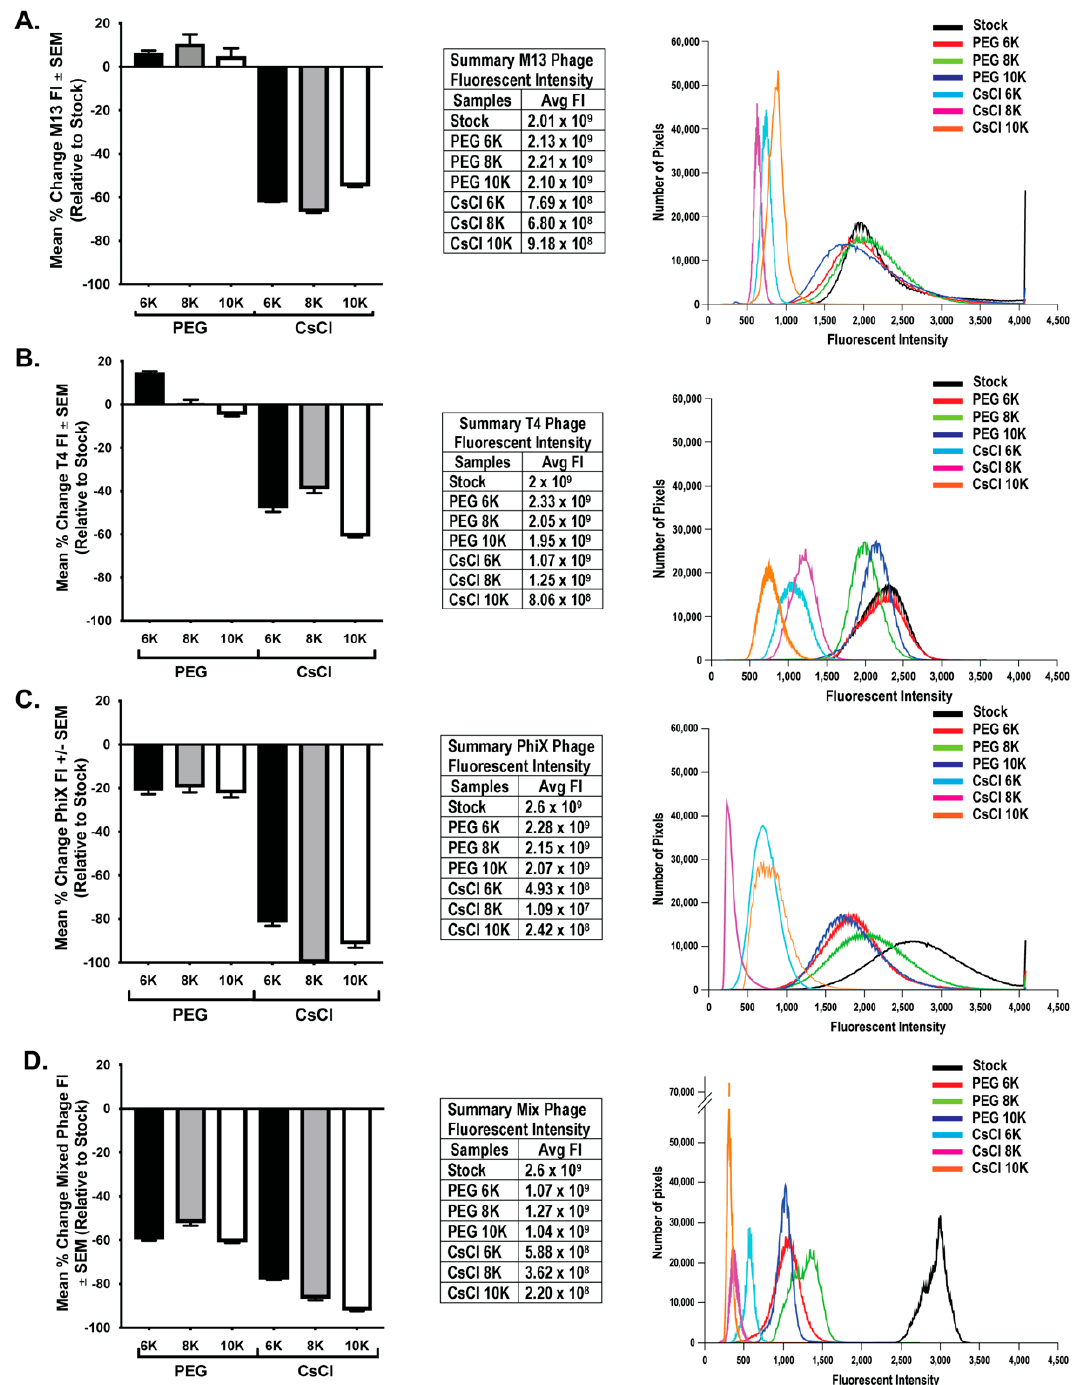
Figure 5. Greater loss of phage nucleic acid after CsCl purification than PEG precipitation. Graphical representation (left panels) of the mean percent change in nucleic acid fluorescent intensity (FI) relative to expected levels after treatments for ( A ) M13, ( B ) T4, ( C ) Φ X, and ( D ) mixed phages. The fluorescent intensity averages for each sample as well as the expected levels (stock) are listed (middle panels) and an overlay of representative histograms for each phage from all samples tested (right panels) show shifts in fluorescent intensities from expected (black lines, stock) of nucleic acid labeling due to treatments.